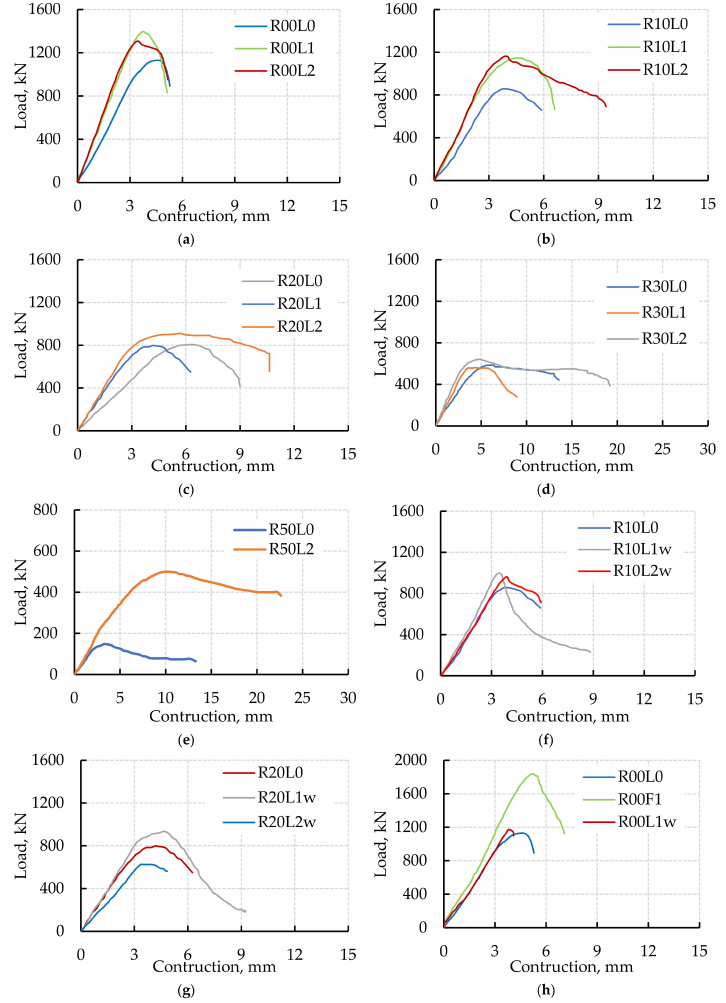
Figure 10. Load contraction curves of the tested columns. ( a ) Columns with Mix0 and CFRP laminates, ( b ) columns with Mix1 and CFRP laminates, ( c ) columns with Mix2 and CFRP laminates, ( d ) columns with Mix3 and CFRP laminates, ( e ) columns with Mix4 and CFRP laminates, ( f ) columns cast with Mix1 and WWM, ( g ) columns with Mix2 and WWM, ( h ) columns with Mix0 and WWM or